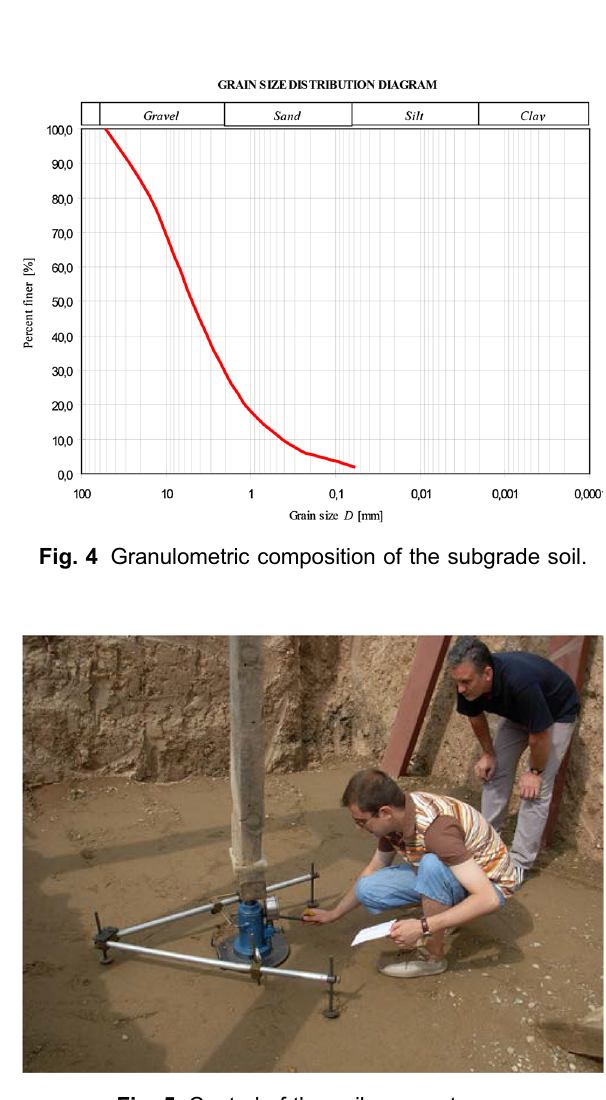
Fig. 5 Control of the soil compactness.